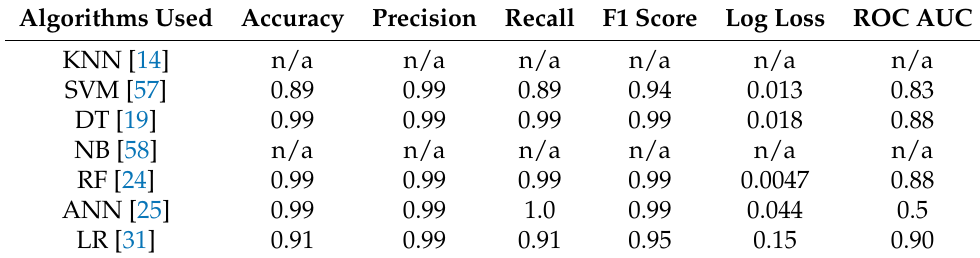
Table 14. DDoS HTTP weighted classes results.